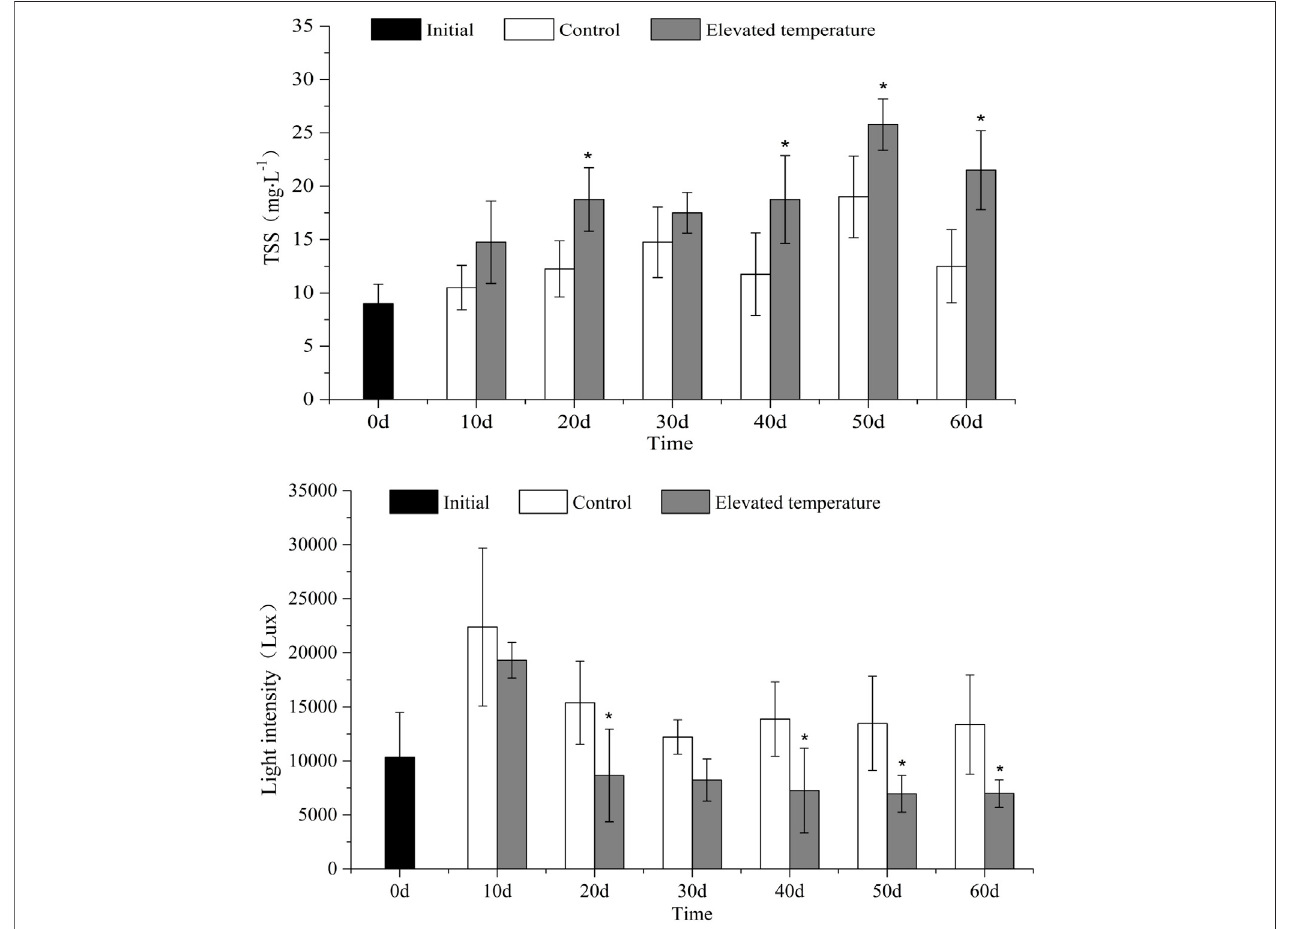
FIGURE 3 | TSS (mean ± SD) and light intensity (mean ± SD) in the different treatments over time. Asterisk indicates signi fi cant ( p < 0.05) differences between treatments.